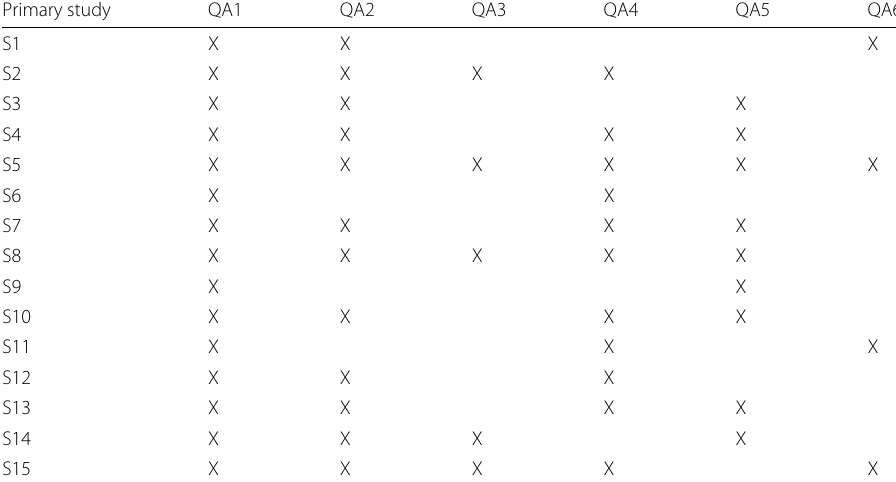
Table 8 Quality assessment for primary